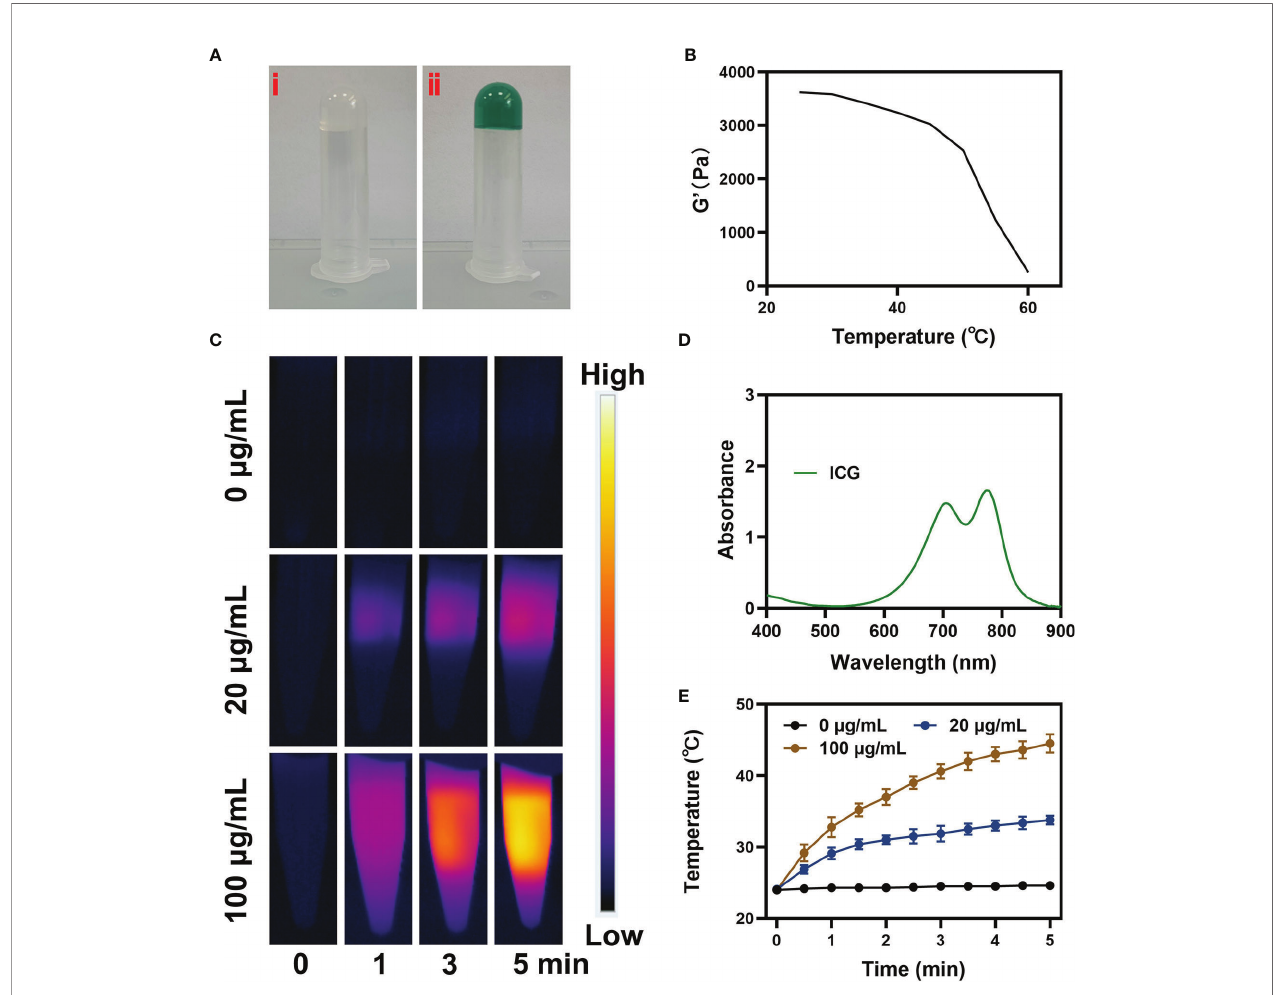
FIGURE 2 | Characterization analysis of ICG. (A) The prepared image of pure hydrogel (i) and CIH (ii). (B) Rheological and temperature curves for the prepared CIH. (C) The corresponding thermal images and (E) photothermal heating curves of CIH at different concentrations (ICG: 0, 20 and 100 m g/mL) under an 808 nm (NIR-I) laser irradiation at a power density of 0.5 W/cm. (D) Absorption spectrum of ICG